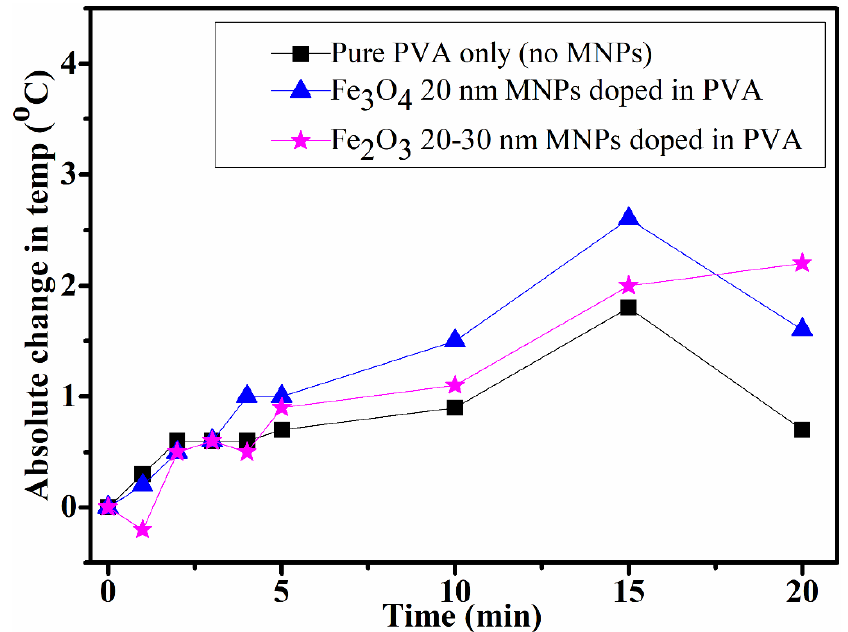
Figure 8. Results obtained by exposing to low-power induction system in DCU lab; absolute change in temperature (°C) vs time (min). in temperature ( ◦ C) vs. time